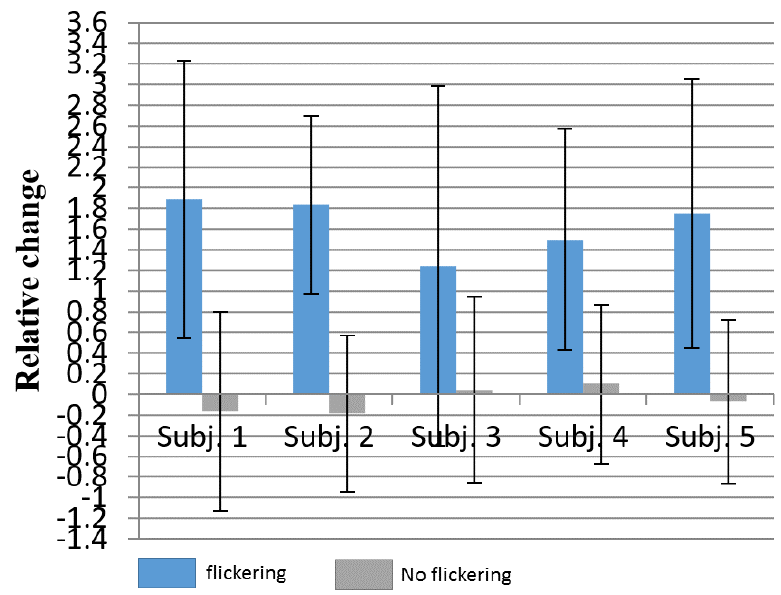
Figure 6. Plot of average relative change ( RC ) values and standard deviations of each subject under flashing and no ‐ flashing conditions.